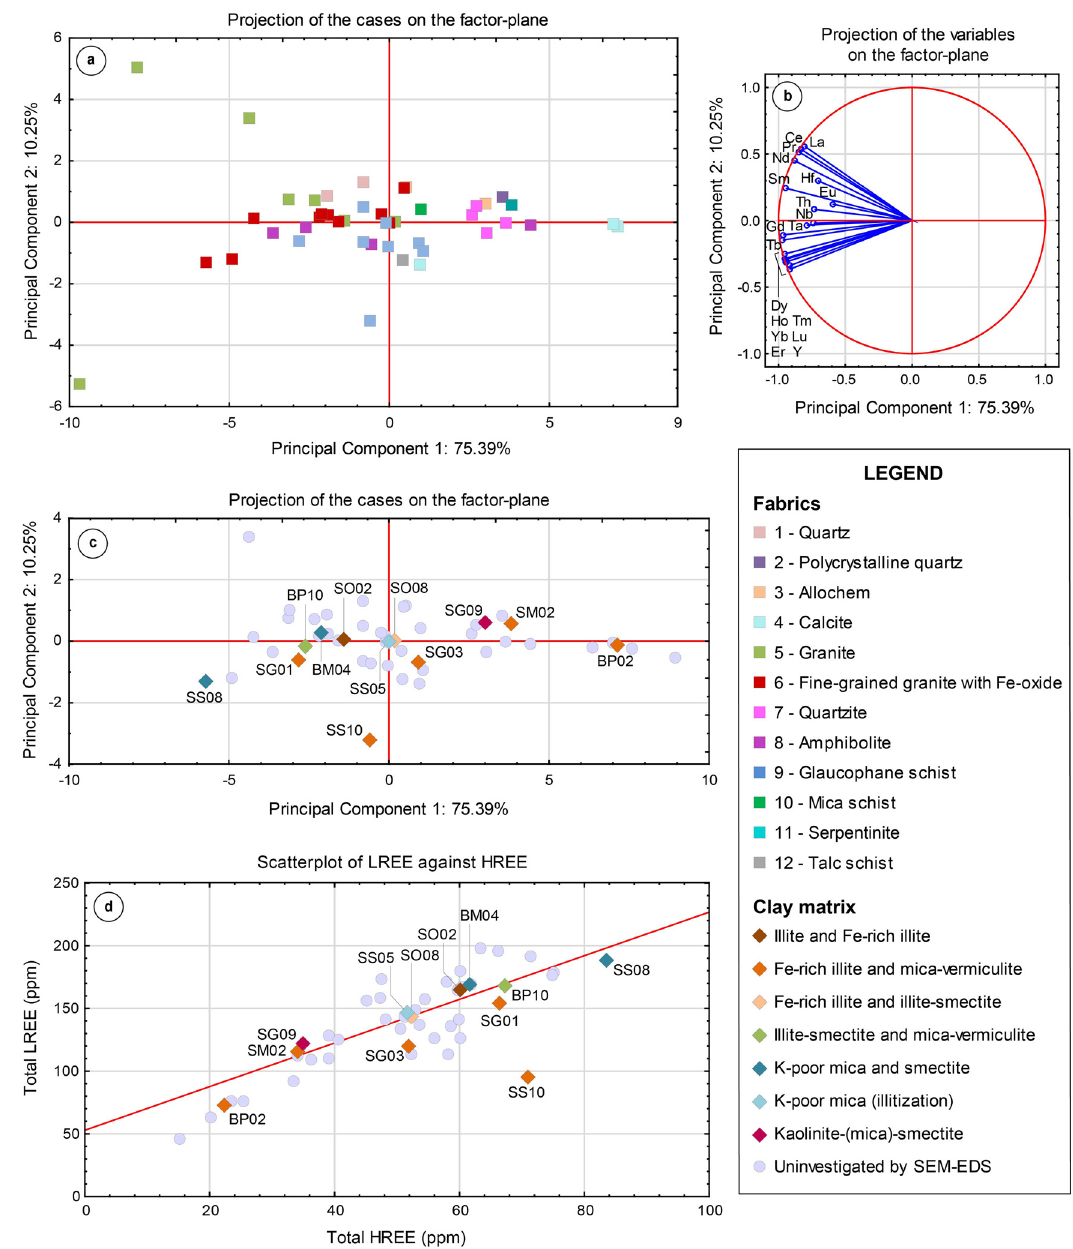
Figure 8: Statistical treatments of geochemical data of analyzed pottery: ( a ) and ( b ) PCA performed considering REE and trace element budget ( Supplementary material 2 ) of the samples for which the lithological assemblage is known – principal com - ponent biplot; ( c ) same principal component biplot of ( a ) with location on the factor plane of the samples for which the SEM - EDS analysis has been executed; ( d ) bivariate plot of LREE versus